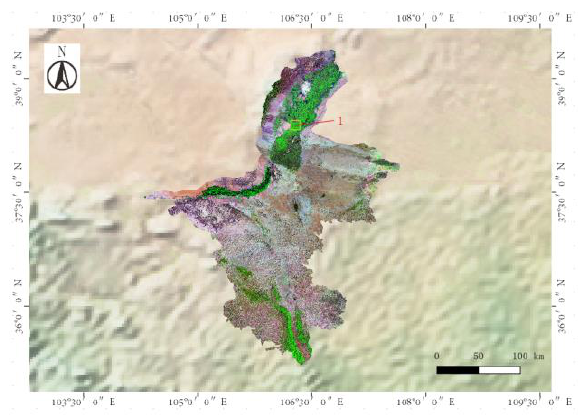
Figure 2 . Location of the